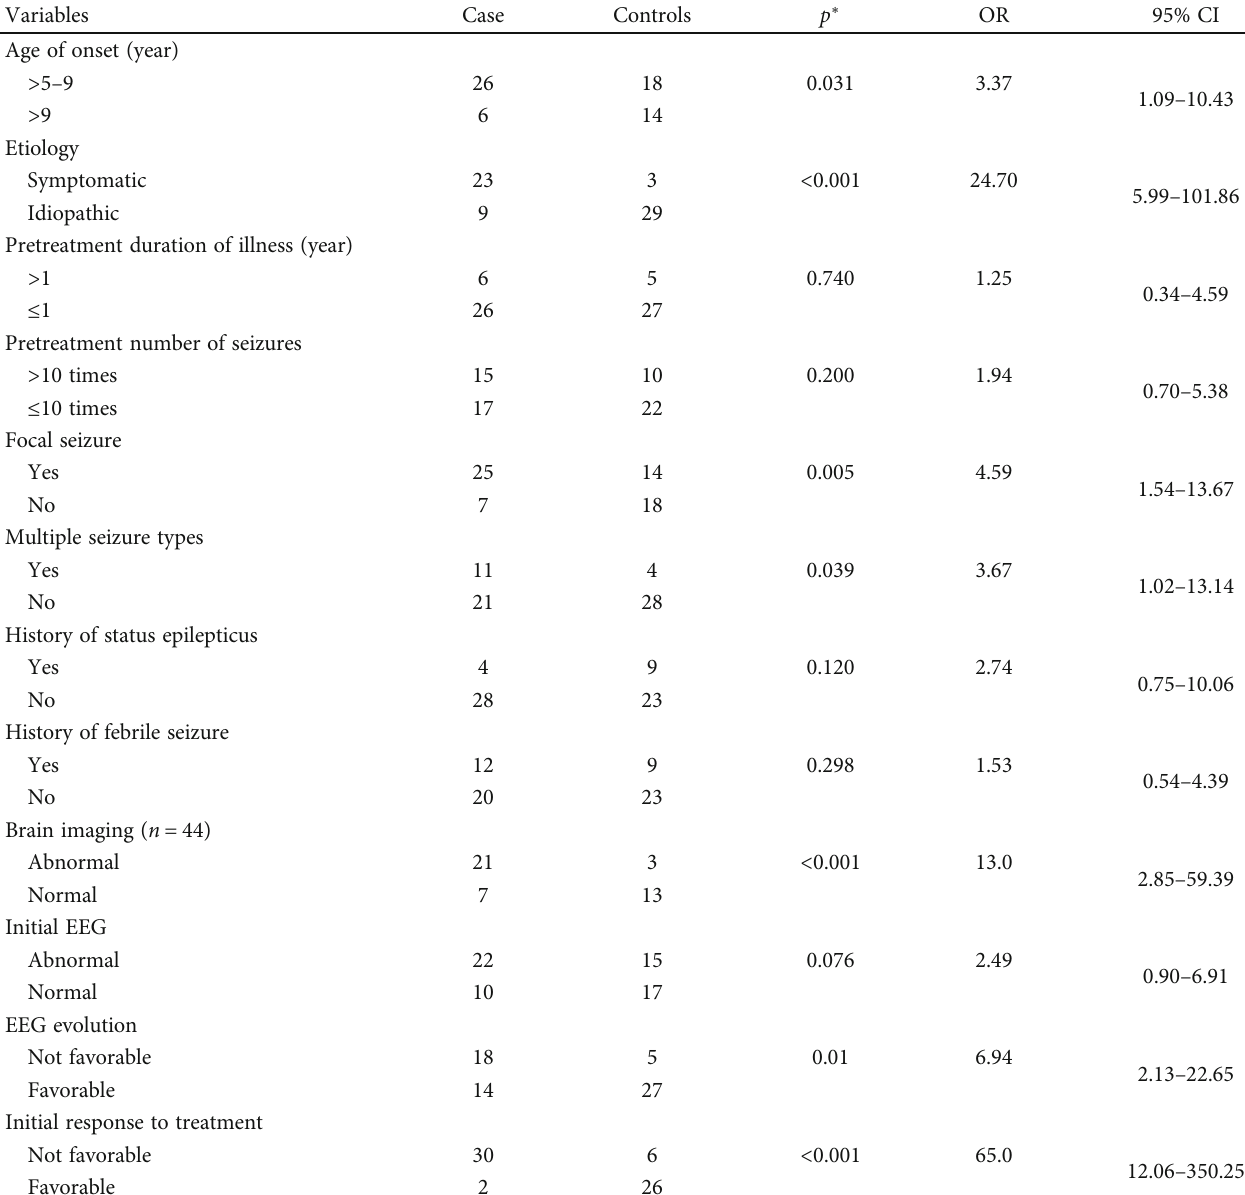
Table 3: Bivariate analysis of factors associated with AED